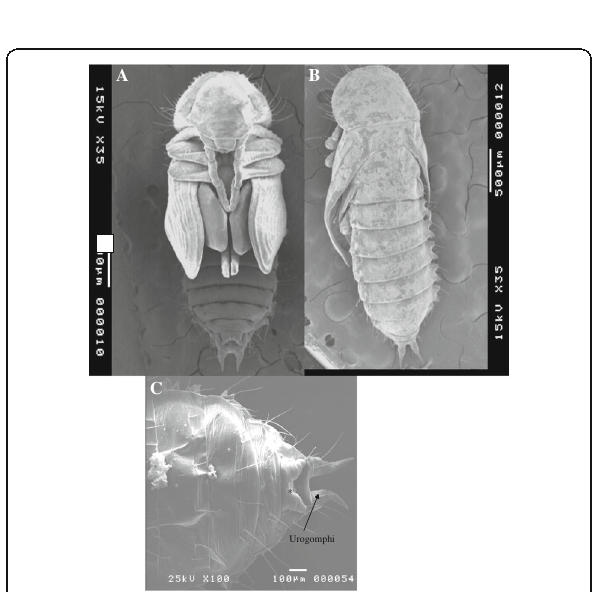
Fig. 11 a SEM of ventral view of female pupa of T. confusum . b SEM of dorsal view of female pupa of T. confusum . c Higher magnification of the ventral view of the last abdominal segment of female pupa showing the genital papillae (asterisk), are two finger-like just anterior to the pointed